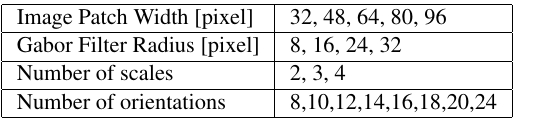
Table 2: Gabor filter parameters we used in the evaluation.